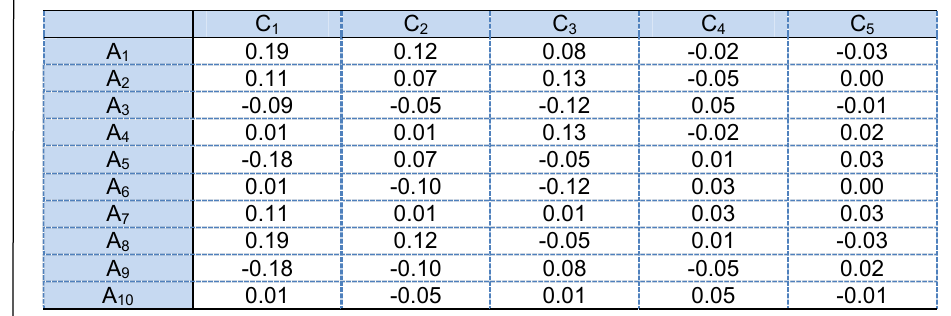
Table 13 – Distance of the alternative from the border approximation area Таблица 13 – Расстояние альтернатив от предельных аппроксимативных областей